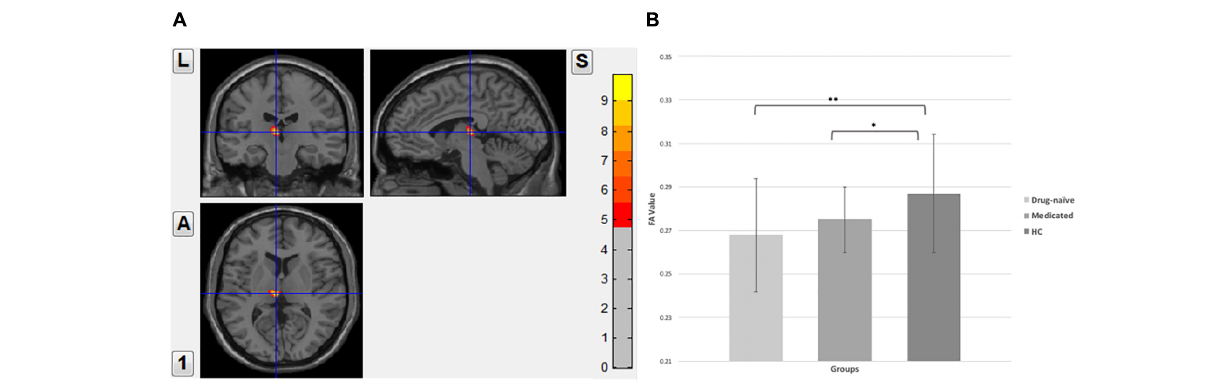
FIGURE 1 | (A) Fractional anisotropy value comparison between the study groups showing abnormalities in the left thalamus, corrected with voxel p < 0.01. (B) Post hoc comparison showing FA values differences between each pair group, ∗∗ significant at p < 0.001, ∗ significant at p <